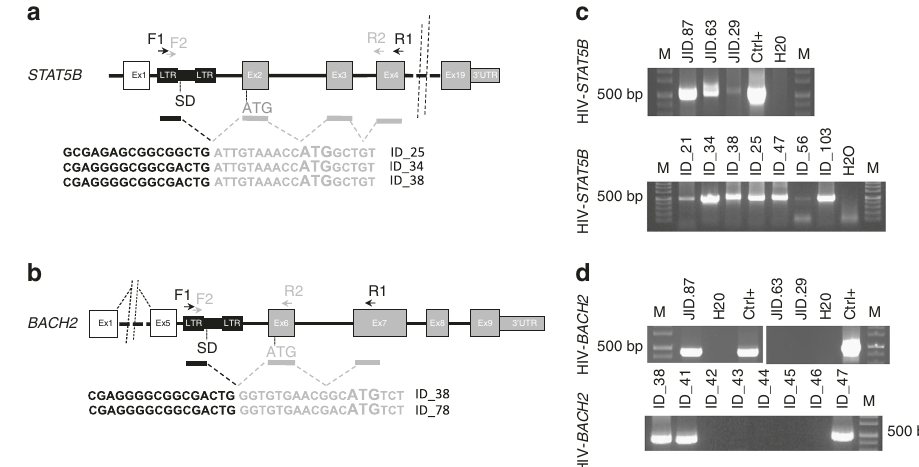
Fig. 1 Identi fi cation of the chimeric HIV/ BACH2 and HIV/ STAT5B transcripts in patients under cART. a , b Scheme of the RT-PCR strategy devised to amplify putative chimeric HIV/ STAT5B ( a ) or HIV/ BACH2 ( b ) transcripts; white and gray boxes represent non-coding and coding exons (Ex), respectively. The exon numbers and the position of the fi rst ATG codon are indicated. The integrated provirus, the LTR, and the 5 ′ major viral SD site are depicted in black . The arrows represent the position of the primer pairs used for RT-PCR. The black and gray bars indicate the ampli fi ed cDNA sequence from the provirus and host genome, respectively. The dashed lines indicate the splicing events. At the bottom of each panel, representative examples of the sequences of the RT-PCR products are shown. c , d Report agarose gel electrophoresis of RT-PCR products of either HIV/ STAT5B or HIV/ BACH2 obtained from PBMC of HIV-1-infected patients using the primers indicated in a , b ; the amplicon size is ~500 bp (M molecular size markers). For each sample, RT- PCR for GAPDH was also performed as positive control of ampli fi cation (data not